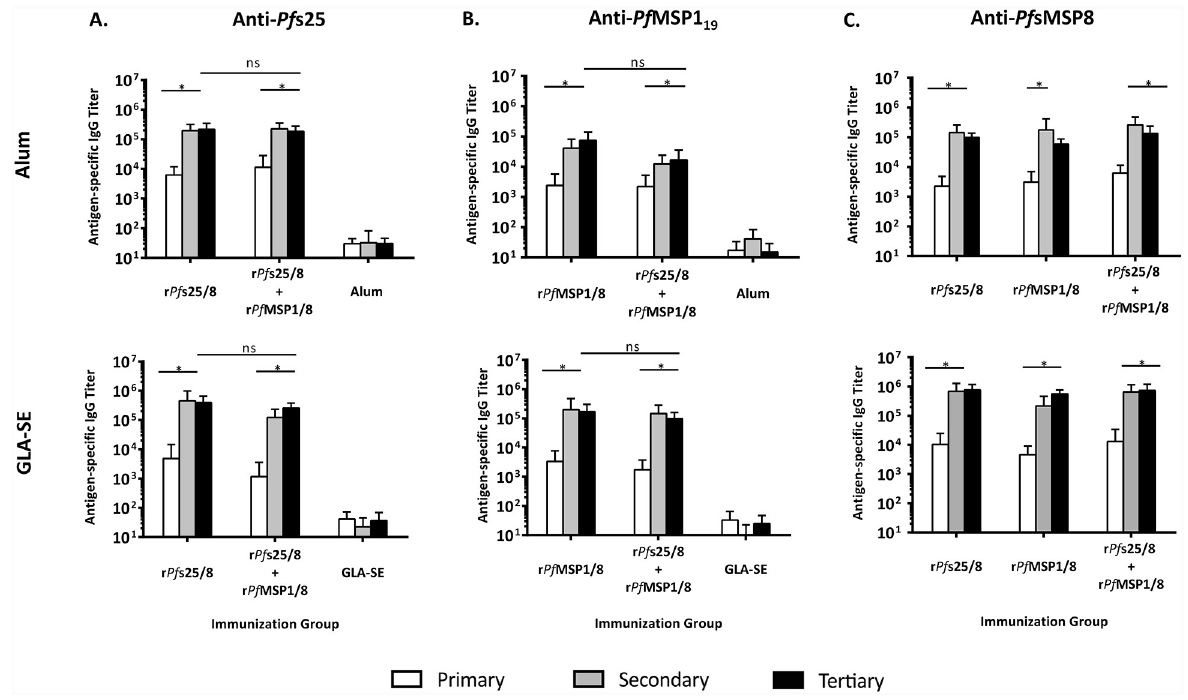
Fig 7. Bivalent formulations containing r Pf s25/8 and r Pf MSP1/8, irrespective of adjuvant, elicit strong titers against both fusion partners with no indication of antigen competition relative to corresponding monovalent vaccines. Sera harvested from groups of CD1 mice (5 male, 5 female) immunized as indicated were analyzed for antigen-specific IgG by ELISA using plates coated with A) r Pf s25, B) rGST- Pf MSP1 19 or C) r Pf MSP8 (0.25 μ g/well). Sera from each adjuvant control group were measured against the corresponding chimeric antigen (r Pf s25/8 or r Pf MSP1/8). Graphs depict mean IgG titers +/- standard deviation. Asterisks over horizontal lines within an immunization group indicate significant boosting of antigen-specific responses over time (Friedman Test; P < 0.05 considered significant). Final IgG titers induced against each component in the bivalent formulations were compared to the corresponding monovalent group (Mann-Whitney U test; P < 0.05 considered significant; ns, not significant).